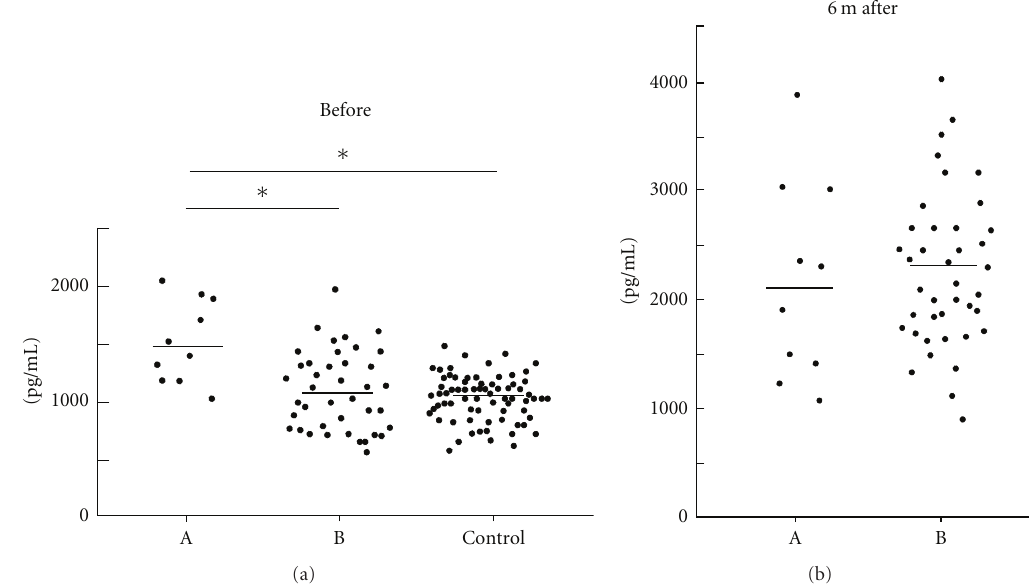
Figure 2: Serum BAFF concentrations of (a, b) (before treatment, at 6 months after the start of therapy) and healthy control subjects. ∗ P < 0 . 05 was statistically significant.